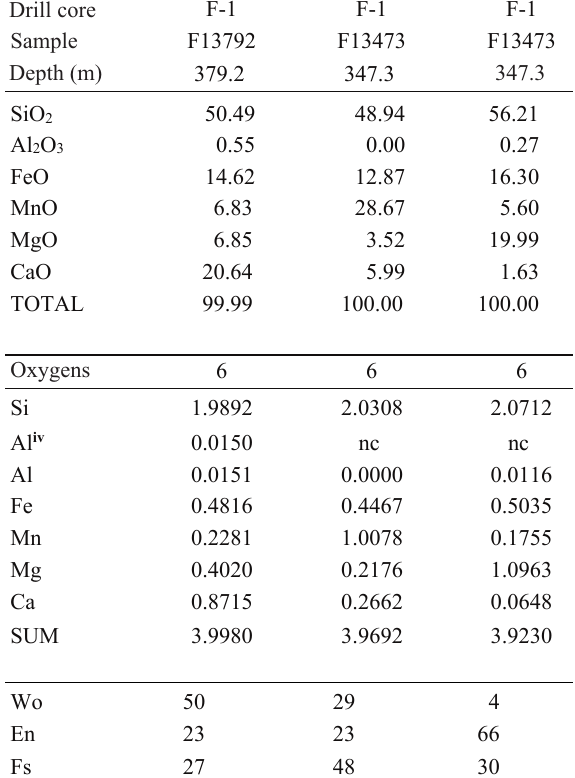
Table 4. Electron microprobe analyses of pyroxene of the Jõhvi magnetite quartzites. Total iron as FeO, cation formula based on 6 O, En = Mg/(Mg + Ca + Fe + Mn); Wo = Ca/(Mg + Ca + Fe +